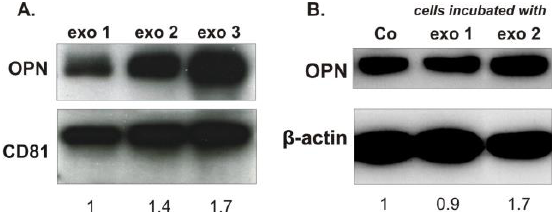
Figure 5. OPN protein levels in exosomes and in MDA-MB-231 cells incubated with these exosomes. ( A ) OPN was more abundant in exosomes isolated from the plasma of rats with breast cancer skeletal metastasis (exo 2 and exo 3) than in exosomes isolated from the plasma of healthy rats (exo 1). ( B ) OPN protein levels were increased in breast cancer cells incubated for 48 h with exosomes isolated from the plasma of rats with breast cancer skeletal metastasis (exo 2). “Co” indicates sample from control MDA-MB-231 cells, which were not incubated with any exosomes; CD81 and β -actin proteins were used as loading